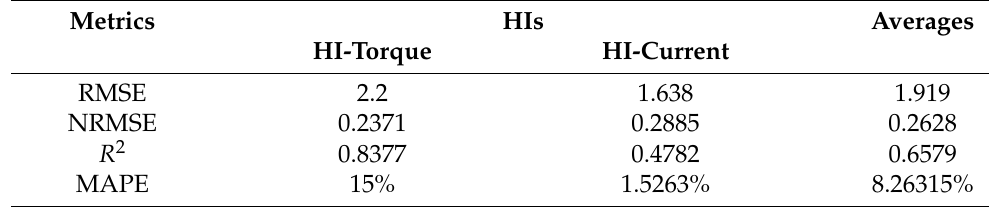
Table 2. RUL prediction